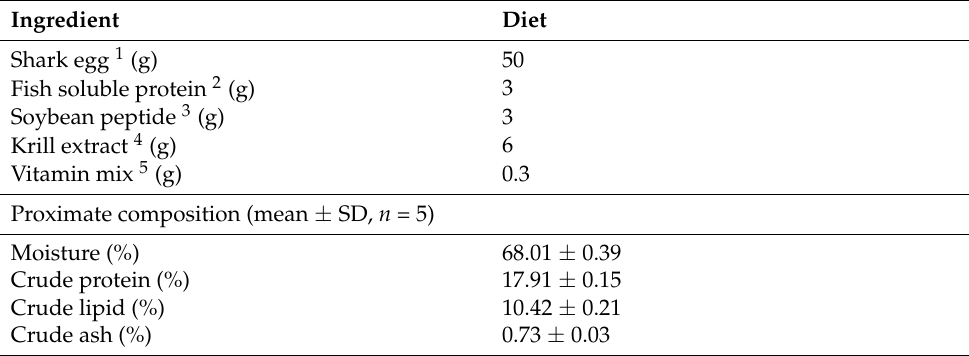
(Table 1). The water flow rate and feed viscosity were approximately 1.0 L/min and 100 mPa · s from 7 to 50 DAH, respectively. The feed (6 mL) was supplied five times daily (09:00, 11:00, 13:00, 15:00, and 17:00) on the bottom of each tank. The water flow was stopped since eel larvae are not good swimmers when feeding. The water flow and feed viscosity were supplied at 1.0 L/min and 100 mPa · s on 7 DAH and increased gradually to 1.5 L/min and 200 mPa · s on 200 DAH with growth. Table 1. Compositions of the slurry-type